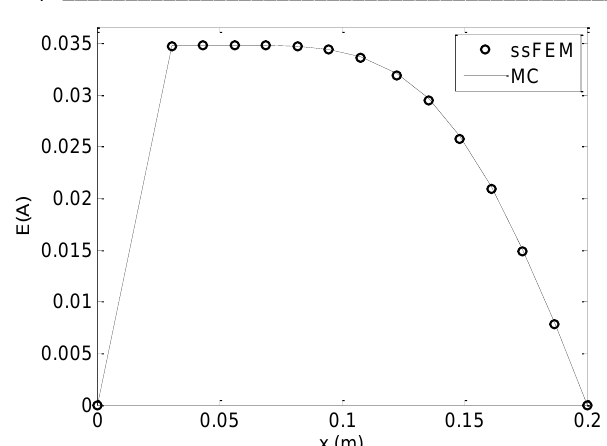
Fig. 5. Mean vector potential (eddy current case) at (x, 0.05) obtained with the Monte Carlo method and with ssFEM.